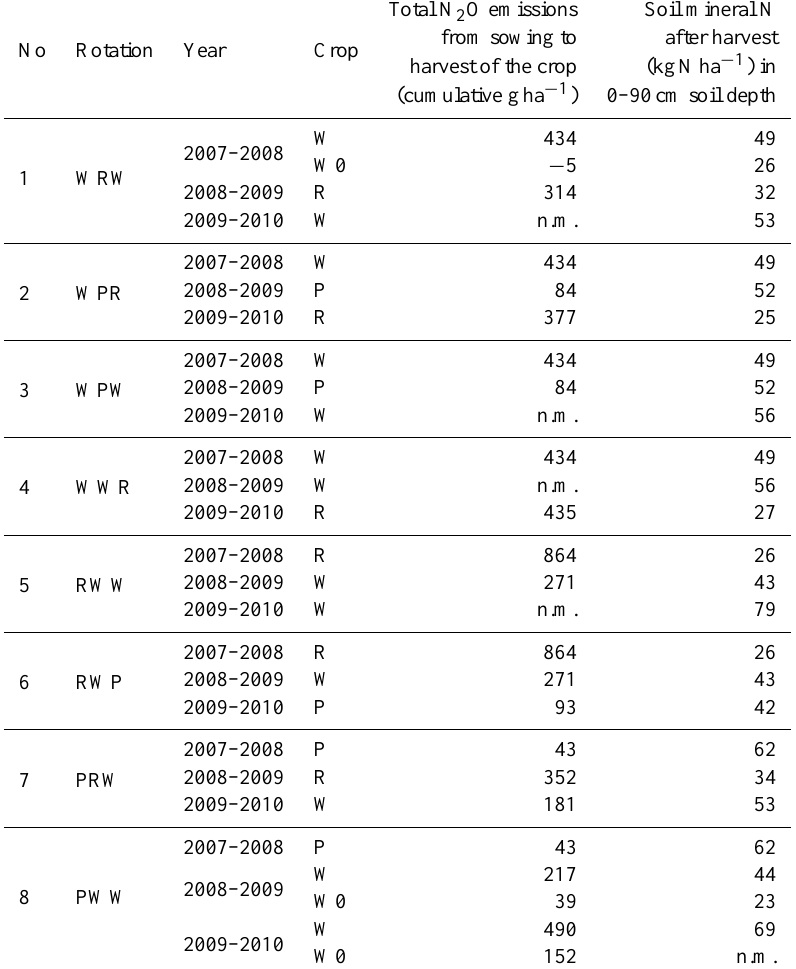
Table 3. Total cropping year emissions data for each treatment and each year (first column, W=winter wheat; R=rape;